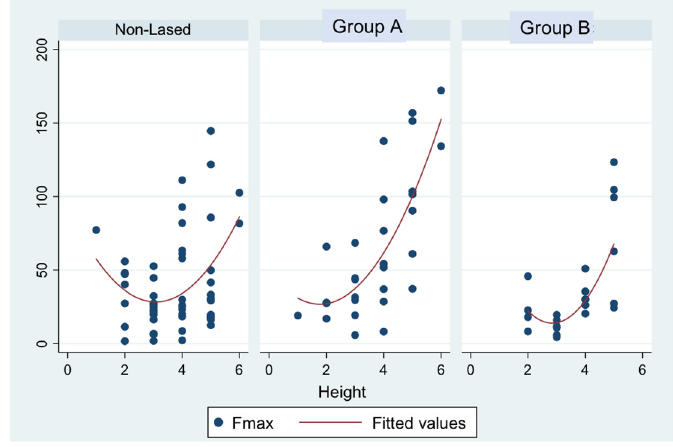
Figure 5. Scatterplots of F-max vs. height by the group with quadratic fitted values.